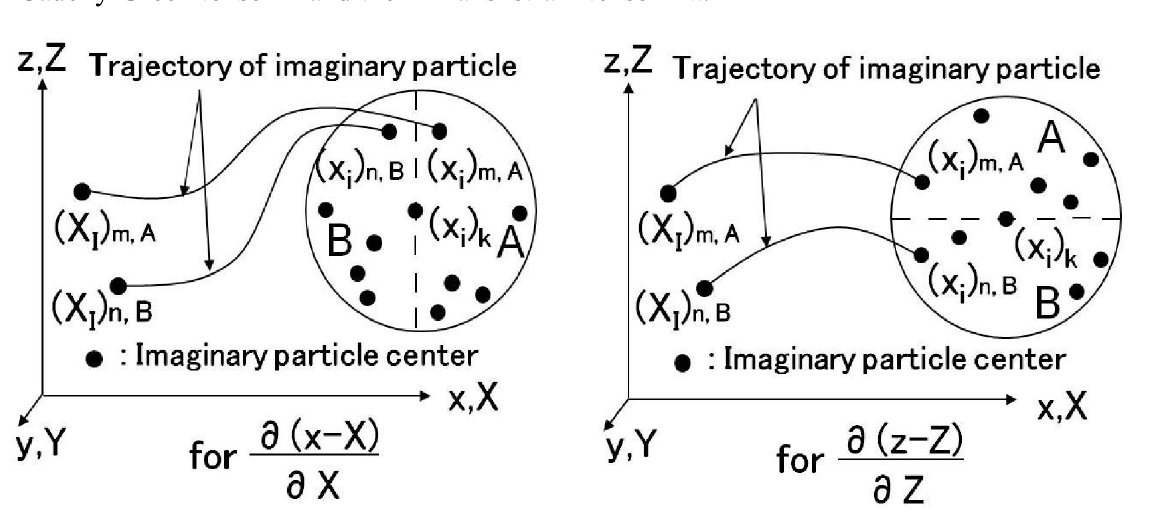
Figure A1. Example of spheres of 1.2h in radius, half spheres (A and B ) and trajectory k of imaginary particle for the calculation of the deformation gradient tensor F , the left Cauchy-Green tensor B and the Almansi strain tensor Ea